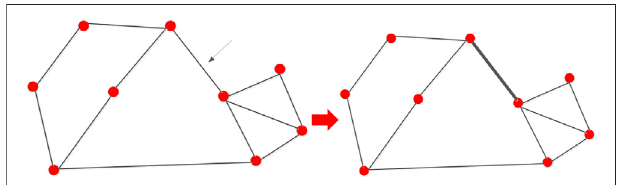
FIGURE 3 | Edge ’ s disturbance schematic